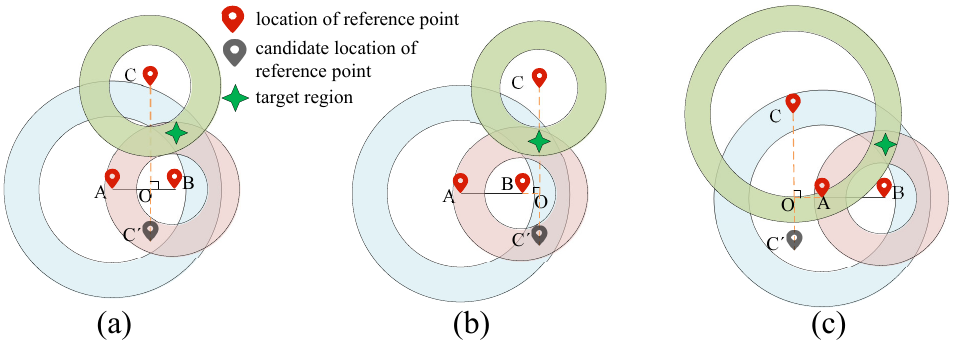
Figure 8. Deployment process of reference points. ( a ) Case 1. ( b ) Case 2. ( c ) Case 3.